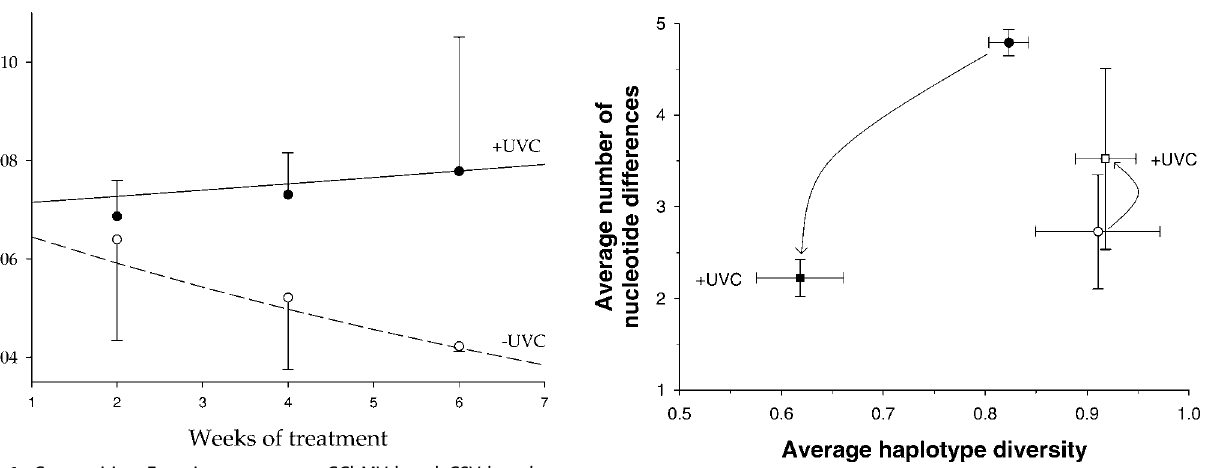
Figure 2. Characterization of the Genetic Diversity of the Competing Viroid Populations Two measures of the genetic diversity ( 6 SEM) of the CChMVd (open symbols) and CSVd (solid symbols) populations 6 wk after initiation of the competition experiments. Three plants were analyzed for each treatment (20 clones of each viroid per plant). Circles represent the averages from control plants and squares the averages from UVC-treated plants. Arrows indicate the direction of the UVC effect.